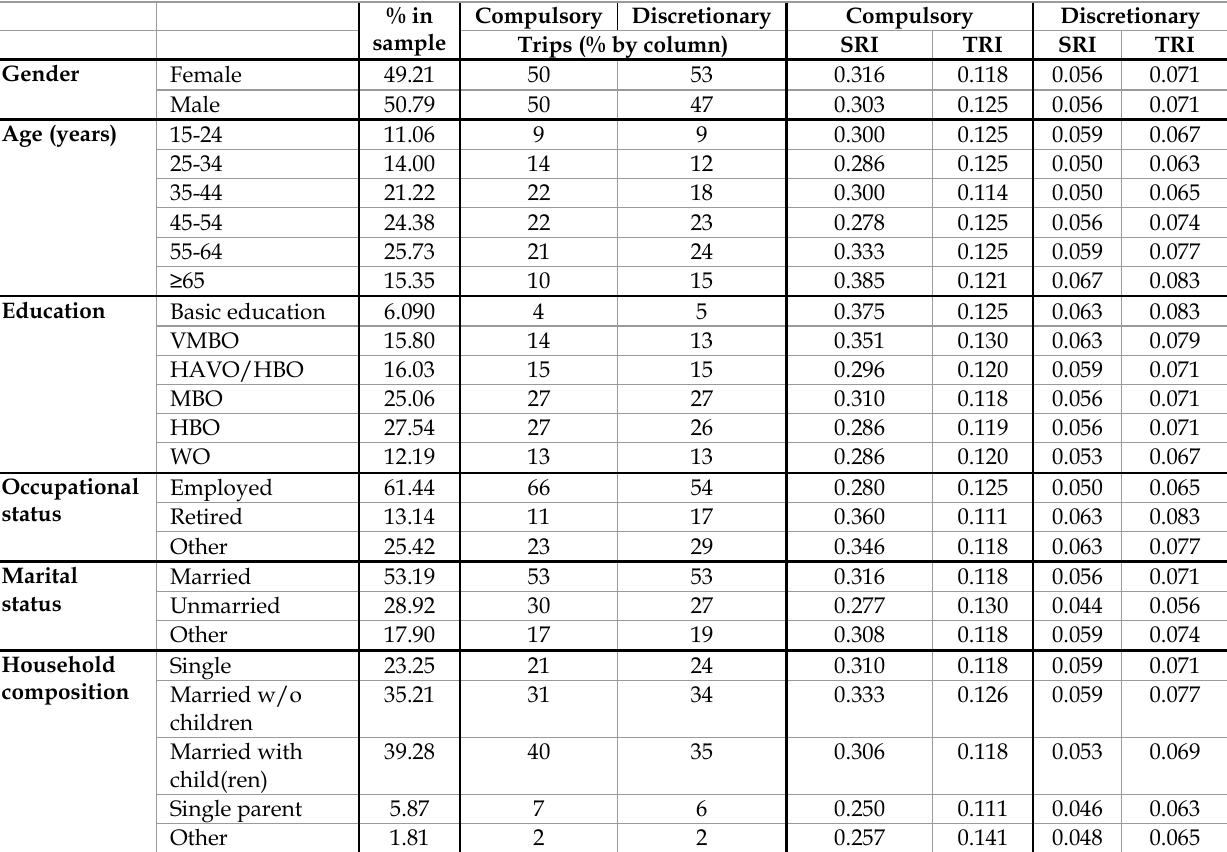
Table 1. Descriptive statistics of socio-economic variables (SRI, TRI,